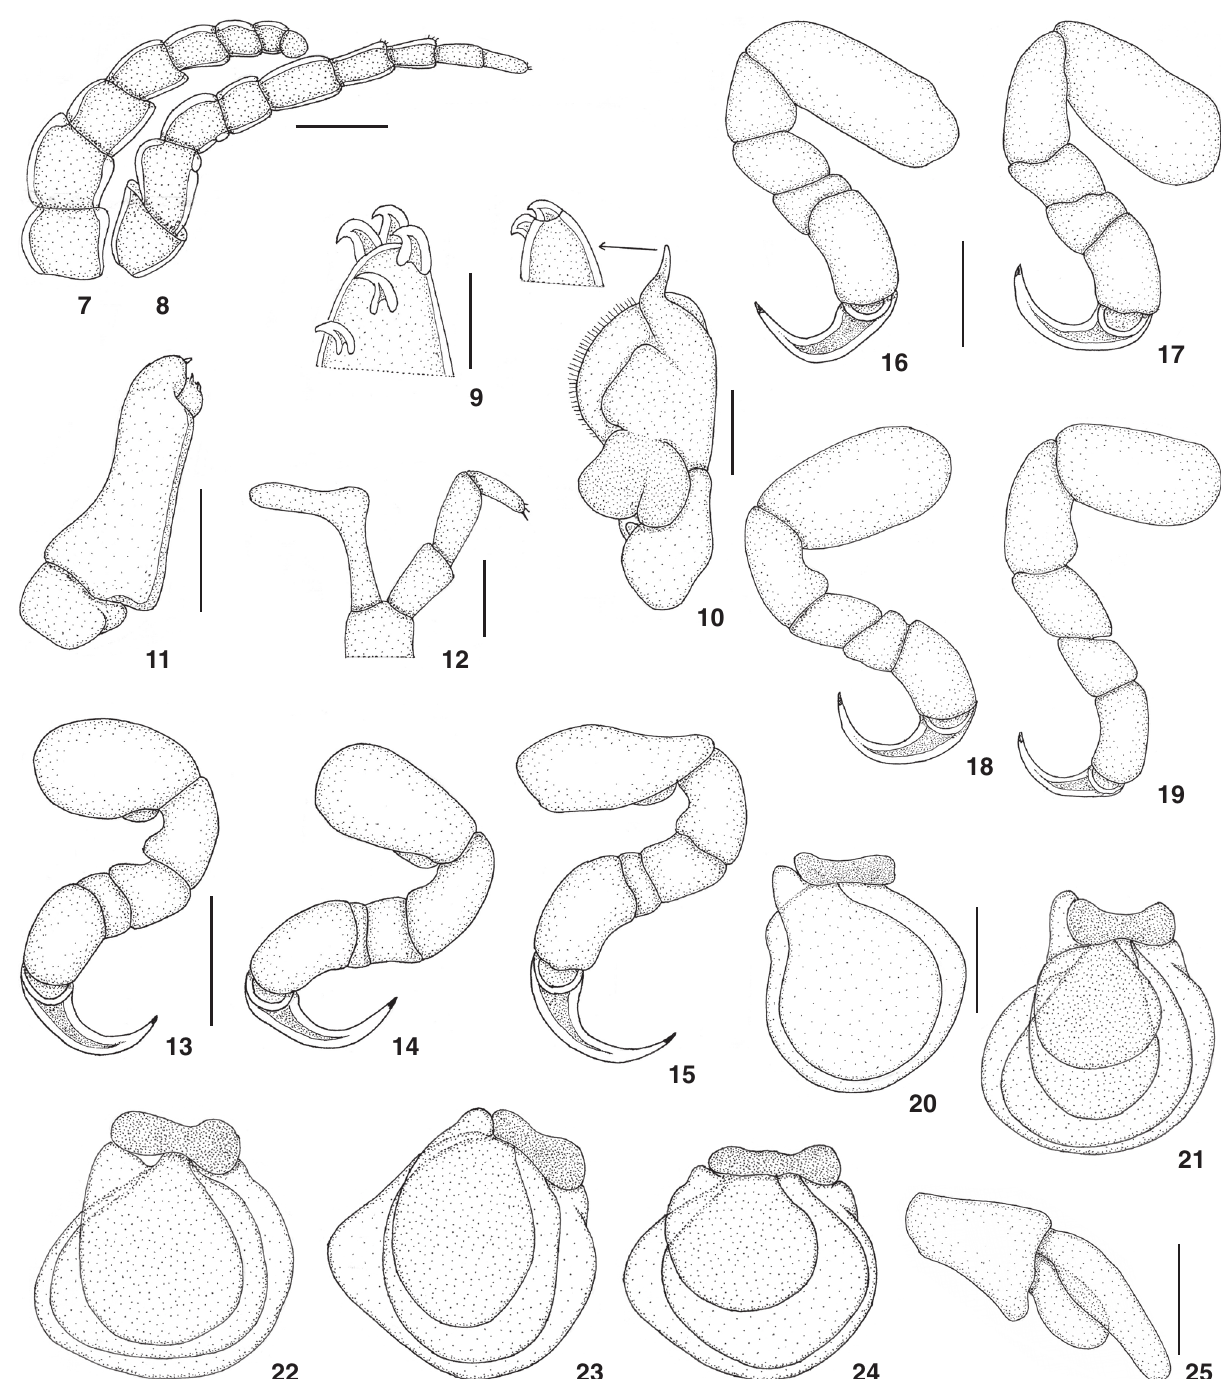
Figures 7-25. Braga cigarra comb. nov. , female: (7) antennule; (8) antenna; (9) maxillule; (10) maxilliped; (11) maxilla; (12) mandible and palp; (13) pereopod 1; (14) pereopod 2; (15) pereopod 3; (16) pereopod 4; (17) pereopod 5; (18) pereopod 6; (19) pereopod 7; (20) pleopod 1; (21) pleopod 2; (22) pleopod 3; (23) pleopod 4; (24) pleopod 5; (25) uropod. Scales: 7-8 = 500 µm, 9-10 = 100 µm, 11 = 1 mm, 12 = 50 µm, 13-19 = 2 mm, 20-24 = 3 mm, 25 = 1